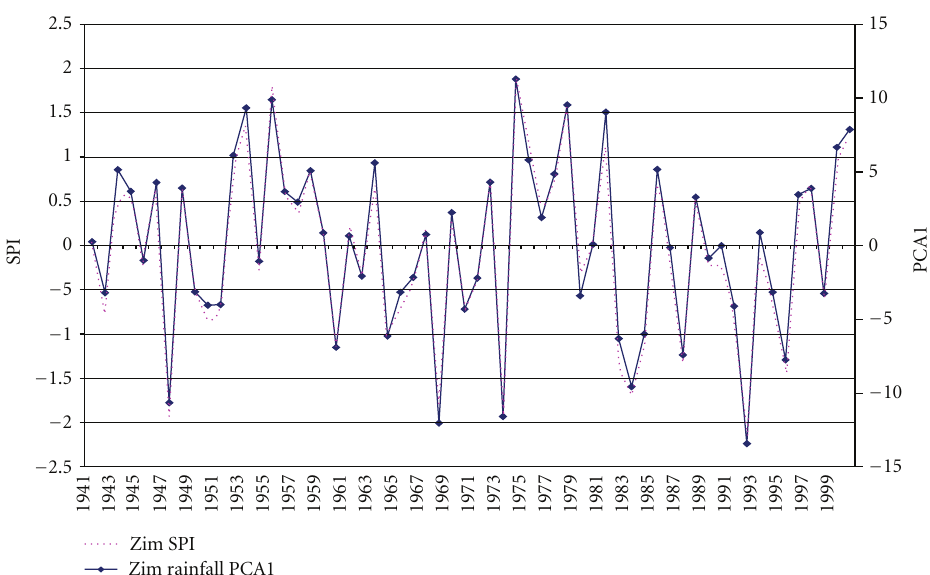
Figure 5: Time series of PC1 alongside Zim SPI for the period from 1941 to 2000.